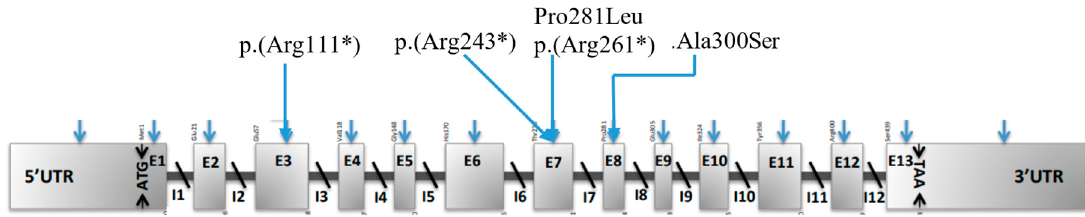
Figure 3. Mutational spectrum in the PAH gene in the Altai Neanderthal.